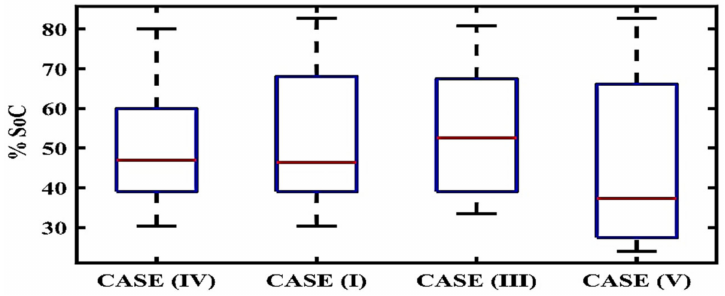
Figure 14. Statistics on the SoC outline for various